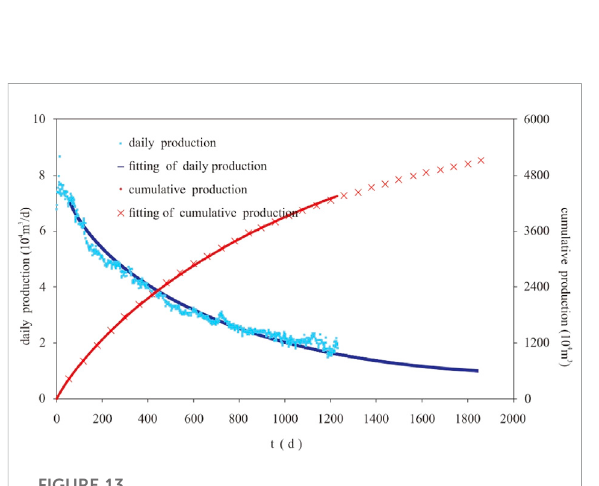
FIGURE 13 Historical fi tting curves of the production and cumulative production of horizontal wells with class II reservoir quality.